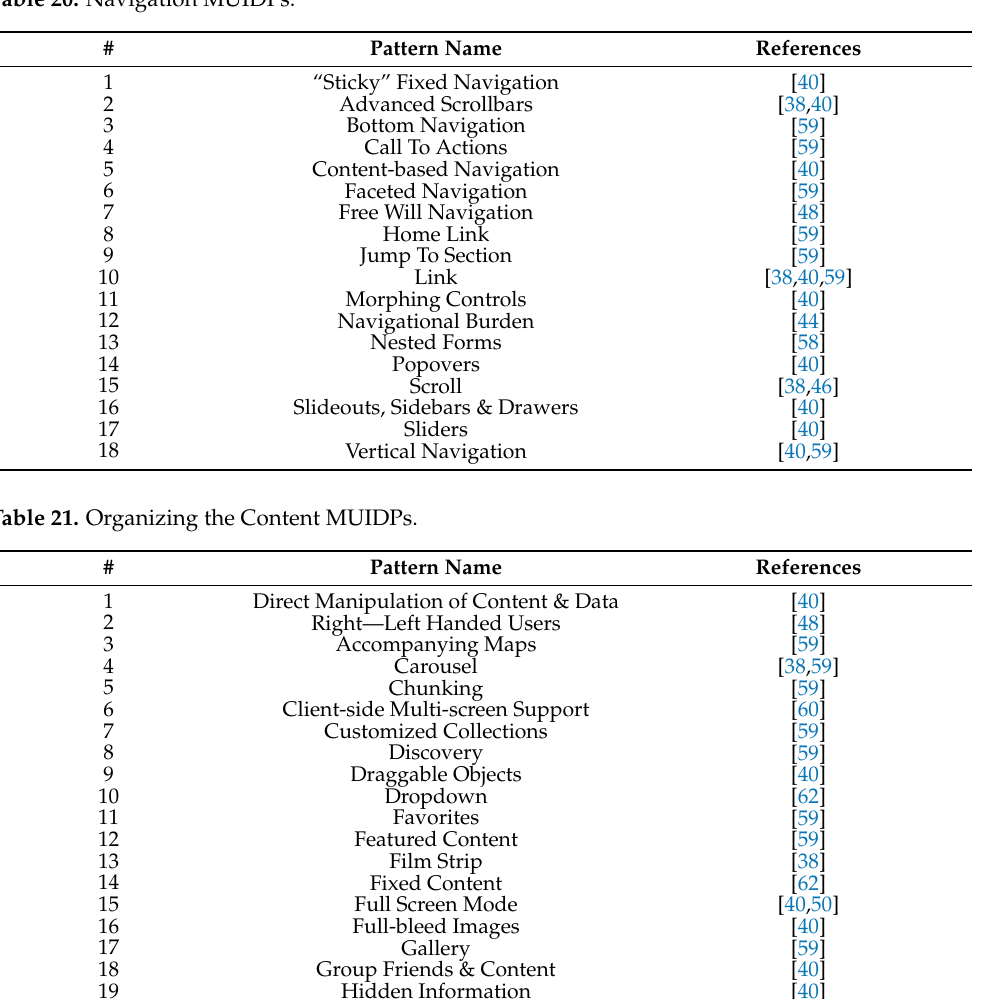
Table 20. Navigation MUIDPs.